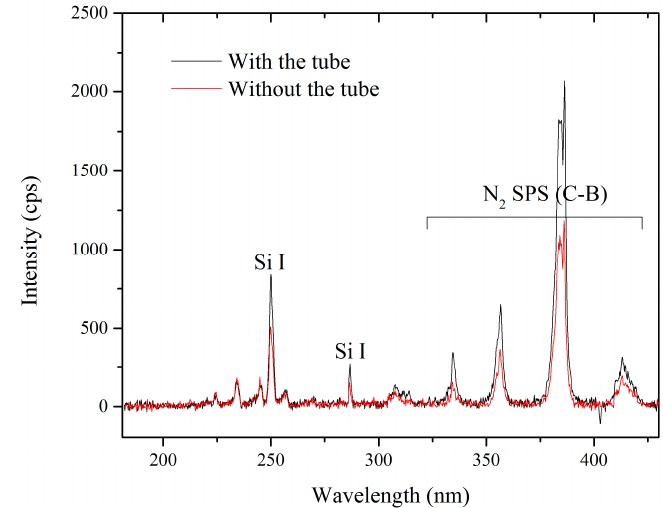
Figure 4. OES spectra acquired from the plasma with and without the quartz tube surrounding the jet-head.